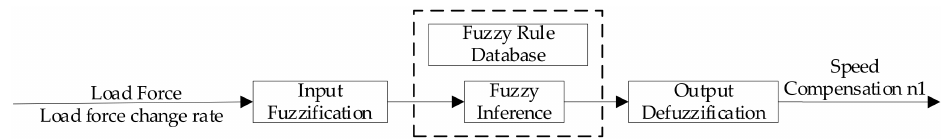
Figure 3. Fuzzy controller design